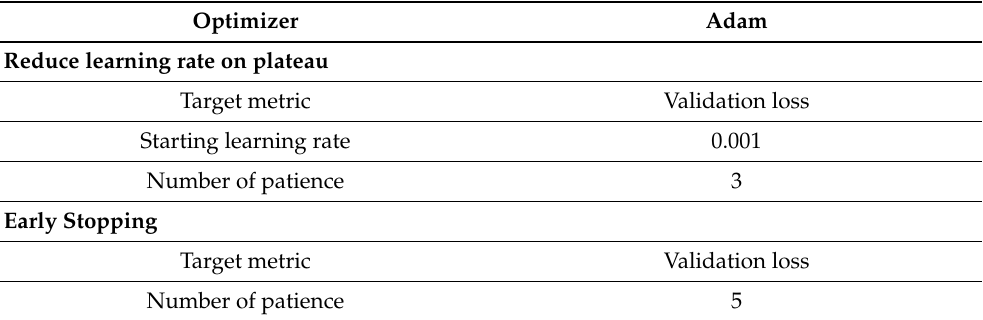
Table A2. Training Hyperparameters.